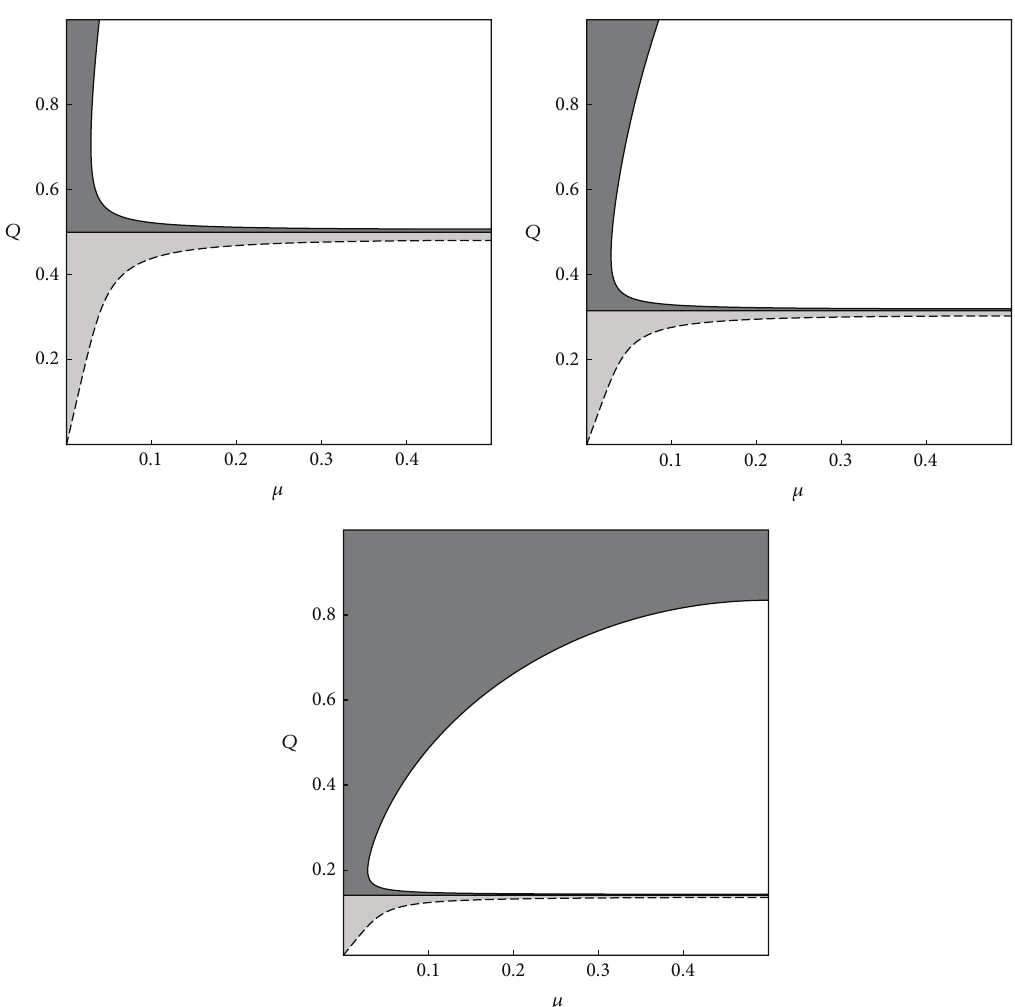
Figure 6: Stability regions of the triangular equilibrium points and the inner equilibrium point 𝐿 1 in the (𝜇,𝑄) plane (𝑄 1 = 𝑄 2 = 𝑄) for 𝜔 = 1, 𝜔 = 0 . 5, and 𝜔 = 0 . 15,